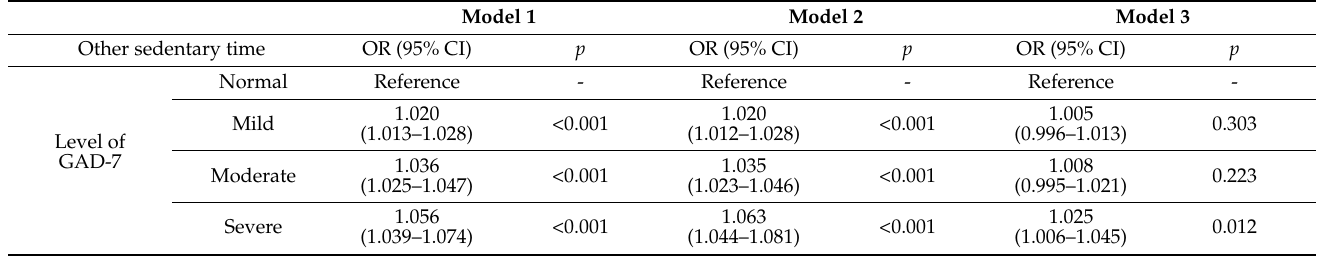
Table 5. Logistic regression analysis to level of GAD-7 based on other sedentary